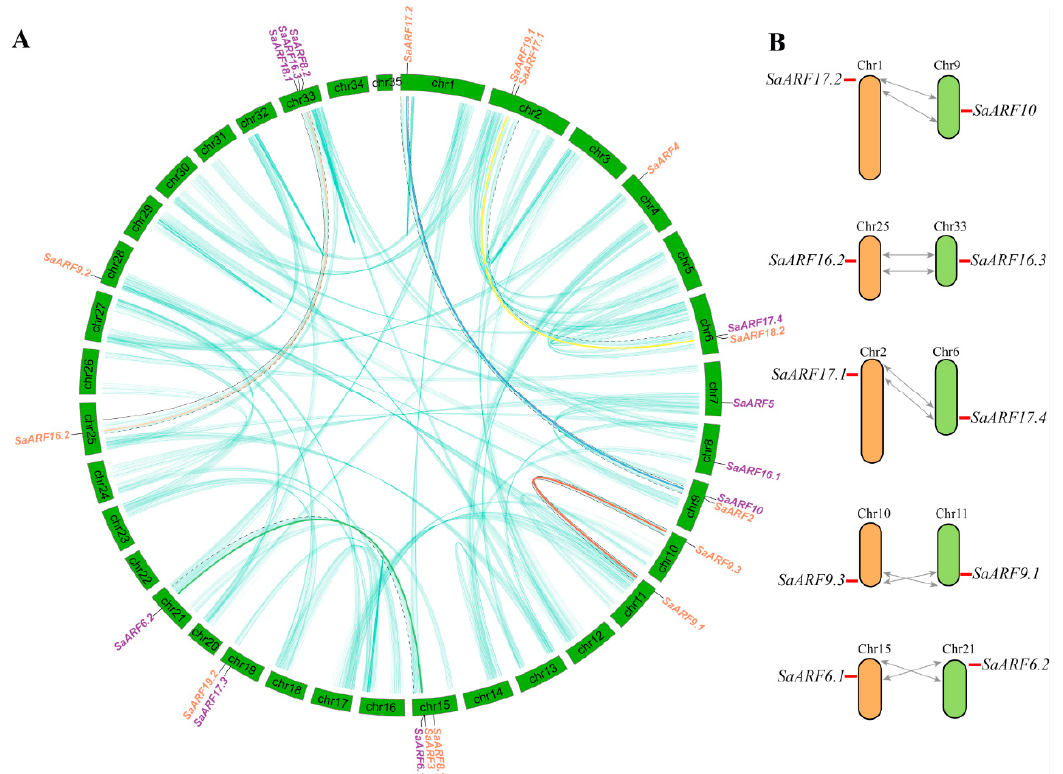
Figure 2. Genomic localization and hypothetical evolutionary histories of SaARFs. ( A ) The distribution of SaARFs in chromosomes and the collinearity relationships throughout the whole genome. The cyan lines indicated the collinearity relationships of genes (except SaARFs ). Other colored lines indicated the collinearity relationships among SaARFs . The genes marked by purple IDs were located in the positive strand of DNA, while others signed by orange IDs were in negative strand. The black dotted lines indicated the collinearity area. ( B ) The grey lines indicated the predicted modes of chromosomal segment